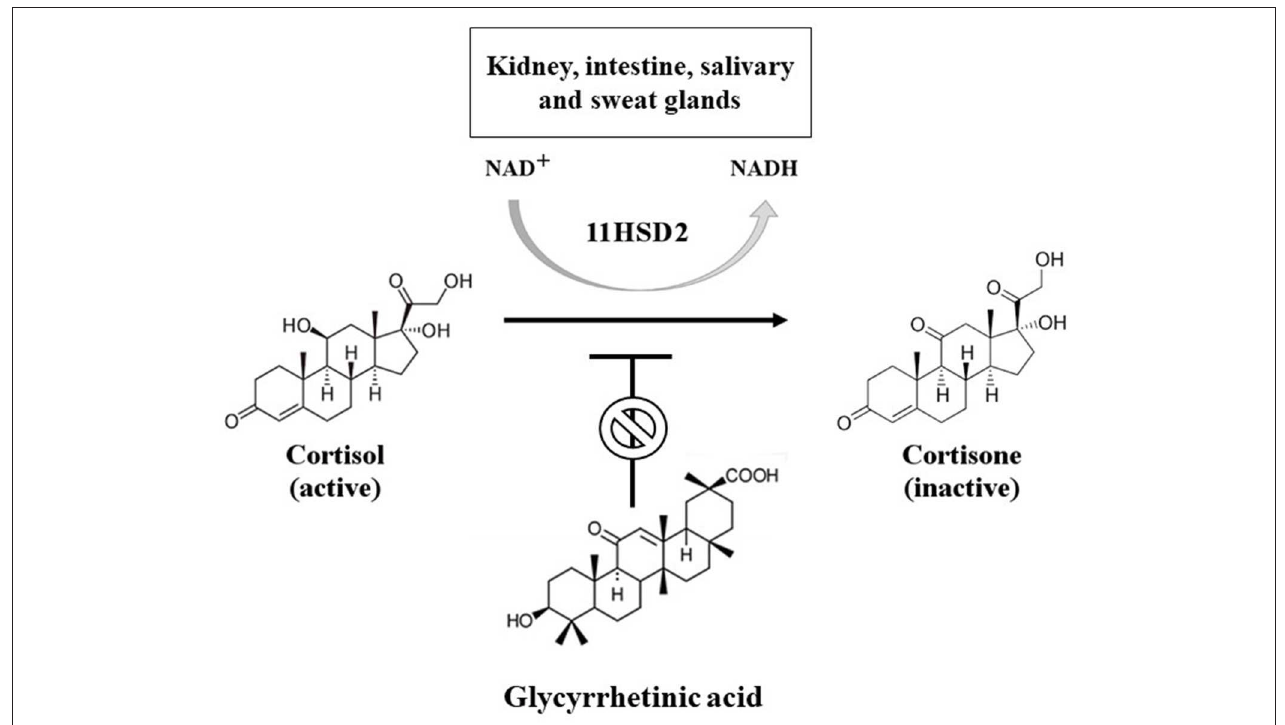
FIGURE 2 | Mechanism of conversion of cortisol into cortisone through 11 beta-hydroxysteroid dehydrogenase 2 (11HSD2). This enzyme is a NAD-dependent dehydrogenase enzyme, mainly expressed in the kidney, intestine, salivary and sweat glands. It can be inhibited by glycyrrhetinic acid, leading to functional mineralocorticoid excess due to unmetabolized cortisol at the level of classical target tissues of aldosterone.